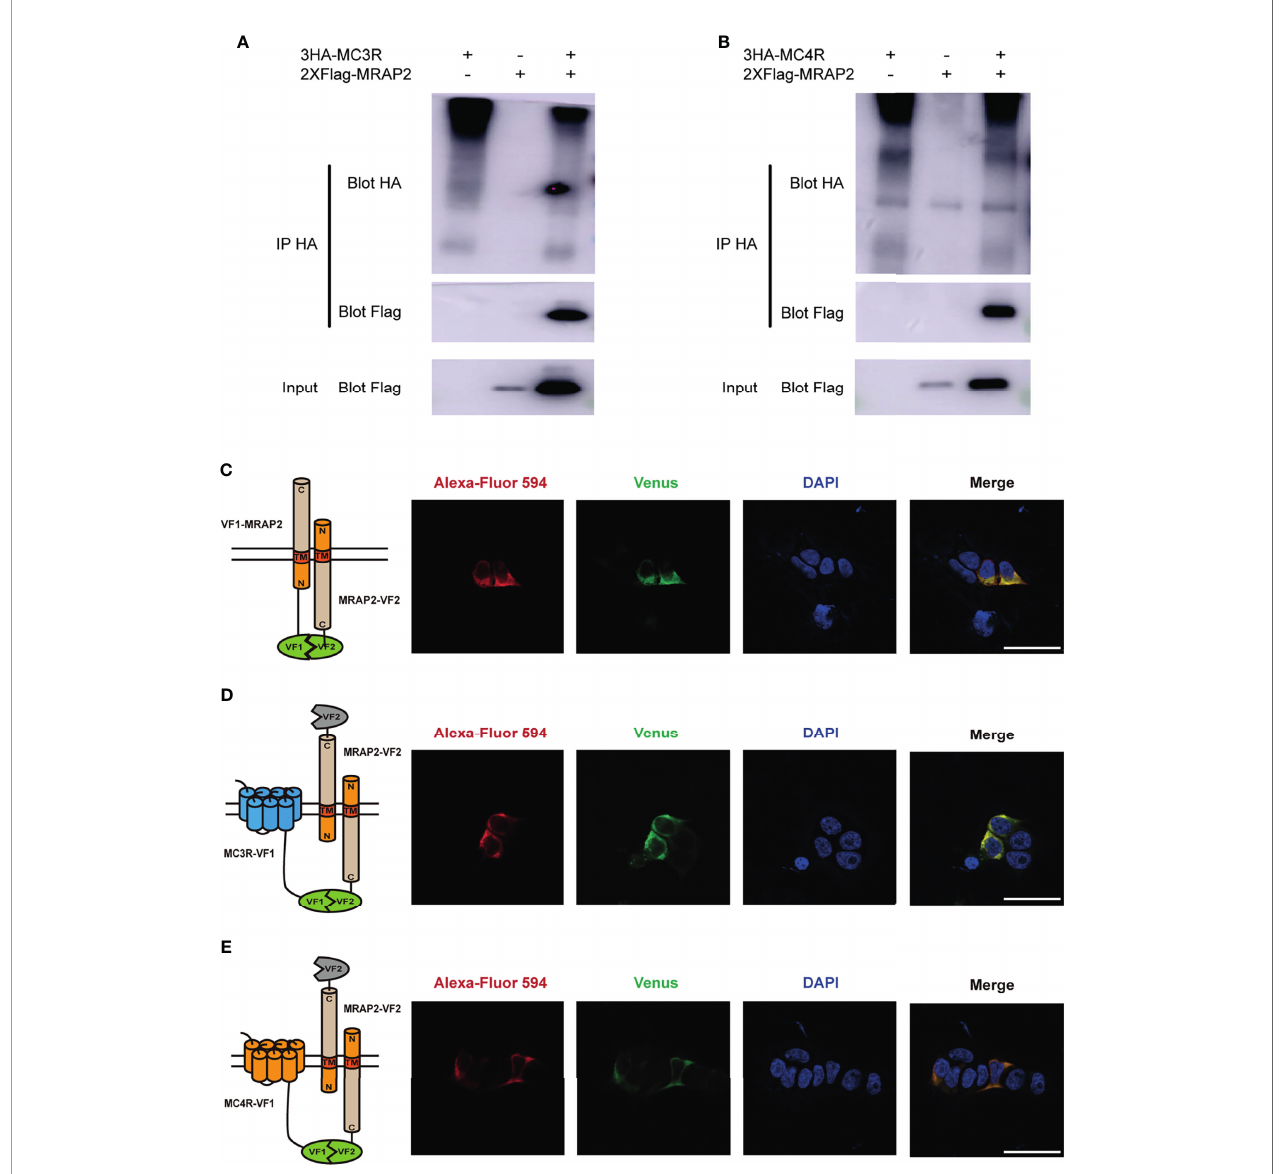
FIGURE 7 | Interaction and co-localization of axolotl MC3R/MC4R and MRAP2 in vitro . (A) Coimmunoprecipitation of 3HA ‐ MC3R with 2xFlag ‐ MRAP2 in HEK293T cells. (B) Coimmunoprecipitation of 3HA ‐ MC4R with 2xFlag ‐ MRAP2 in HEK293T cells. (C) Confocal microscopy of the co-localization of MRAP2-VF1 and MRAP2- VF2 on the plasma membrane. (D) Confocal microscopy of the co-localization of MC3R and MRAP2 on the plasma membrane. (E) Confocal microscopy of the co- localization of MC4R and MRAP2 on the plasma membrane. Nuclei stained with DAPI are shown in blue and Venus fl uorescence in green. Surface expression of MC3R/MC4R, and MRAP2 is shown in red, detected by anti ‐ Flag antibody and secondary anti ‐ rabbit Alexa Fluro 594 (Abcam). Scale bar = 50